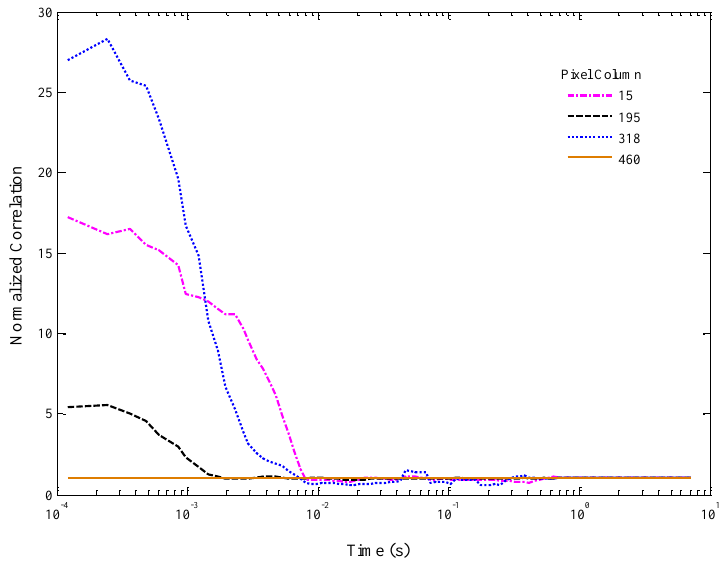
Figure 7. Normalized autocorrelation functions for selected columns of the simulated data in Figure 5.